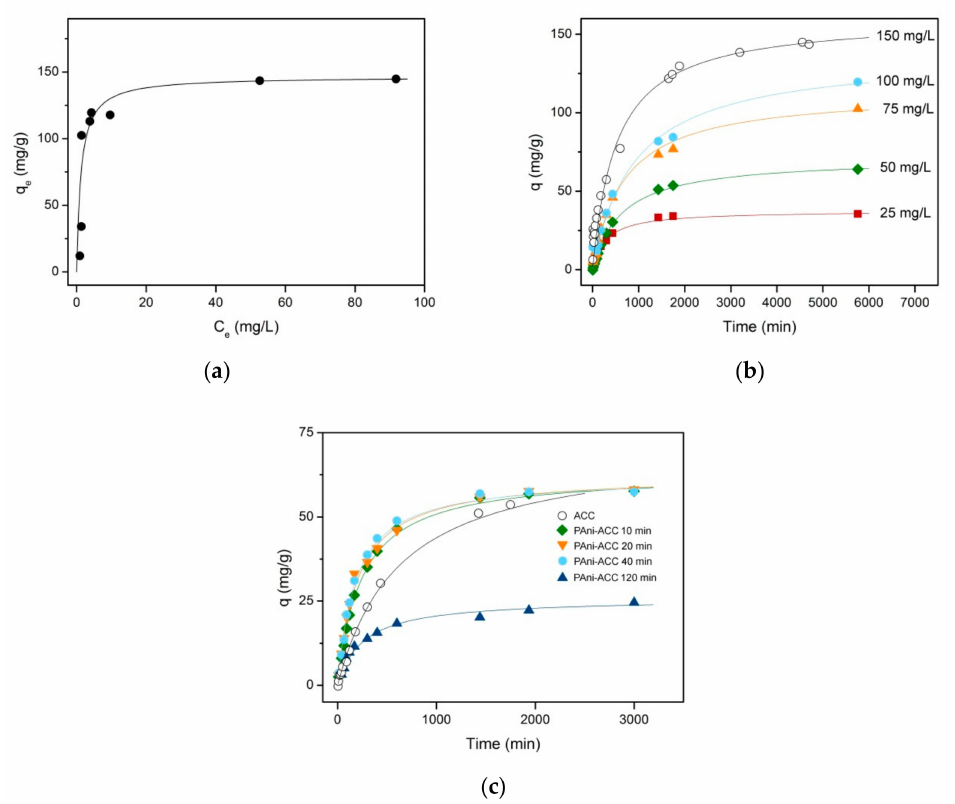
Figure 10. ( a ) Experimental (solid symbols) and Langmuir-based simulated adsorption isotherm (solid line) for Acid Red 27 on untreated ACC at 25 ◦ C; ( b ) Experimental (symbols) and PSO modelled (solid lines) kinetic curves for the adsorption of Acid Red 27 on untreated ACC at di ff erent initial dye concentrations; ( c ) Experimental (symbols) and PSO modelled (solid lines) kinetic adsorption curves of 50 mg L − 1 Acid Red 27 solution onto hybrid PAni-ACC composites formed at di ff erent electropolymerization times. Table 4. Pseudo-first-order and pseudo-second-order kinetic parameters for the adsorption of